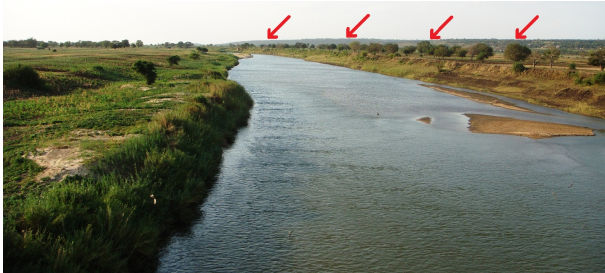
Figure 16. The Limpopo River flowing next to Chibuto; elevated sandy levees can be observed at the horizon on the right side, as indicated by the red arrows (photographer: De Dapper,